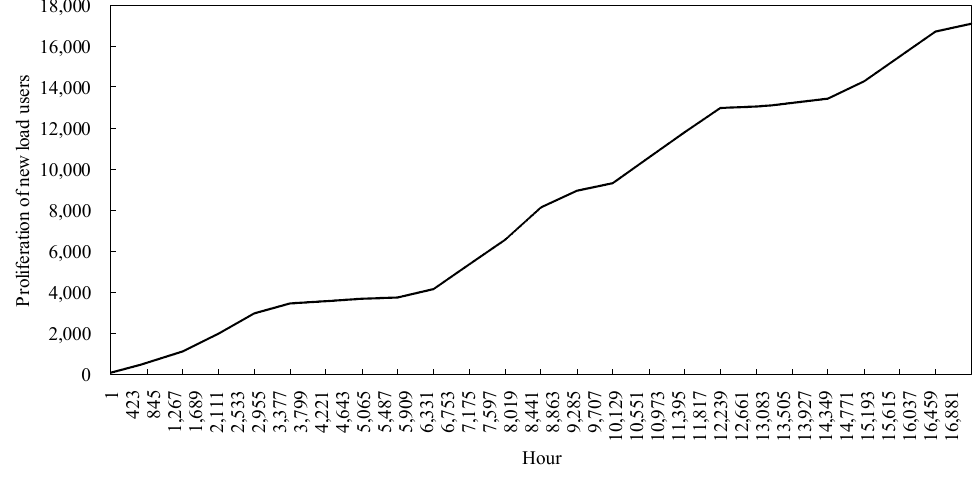
Figure 11. Diffusion of load users.